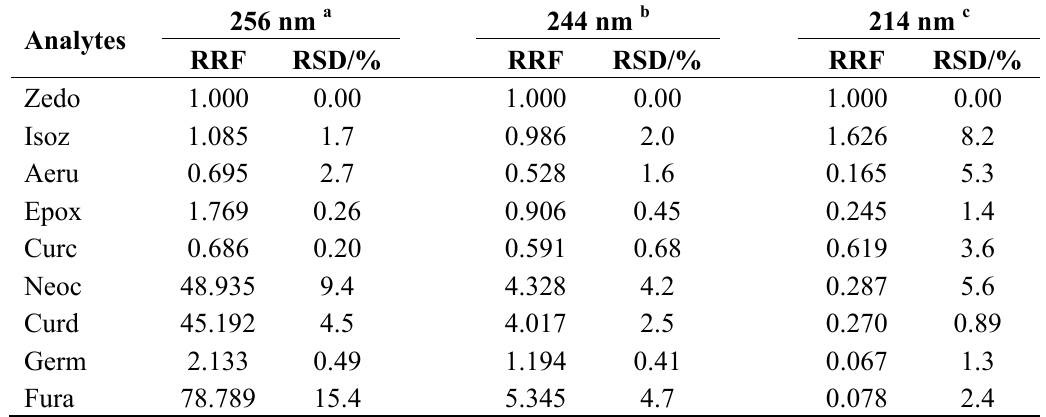
Table 4. The relative response factors (RRFs) for sesquiterpene standards against